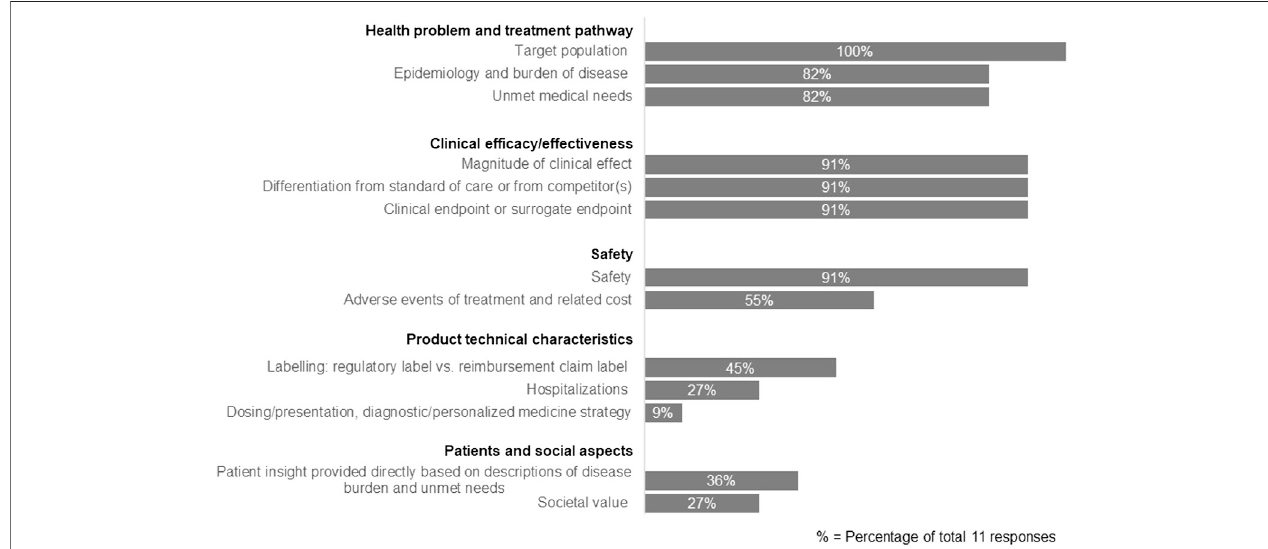
FIGURE 2 | Components included in the TPP that re fl ect HTA/payer